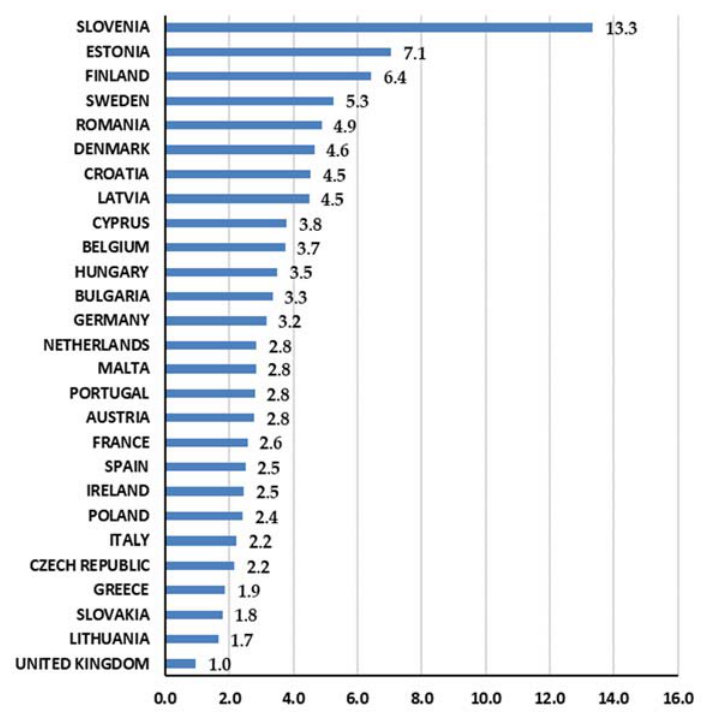
Figure 3. Percentage distribution of the FEMP by employment generated for the period 2014–2020.